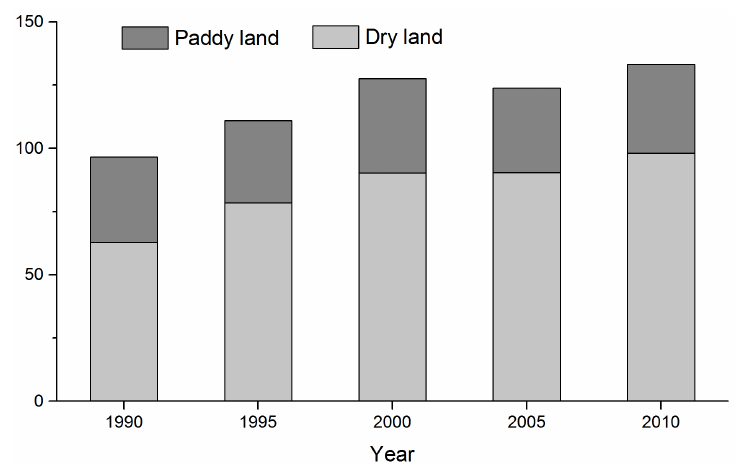
during past 20 years E